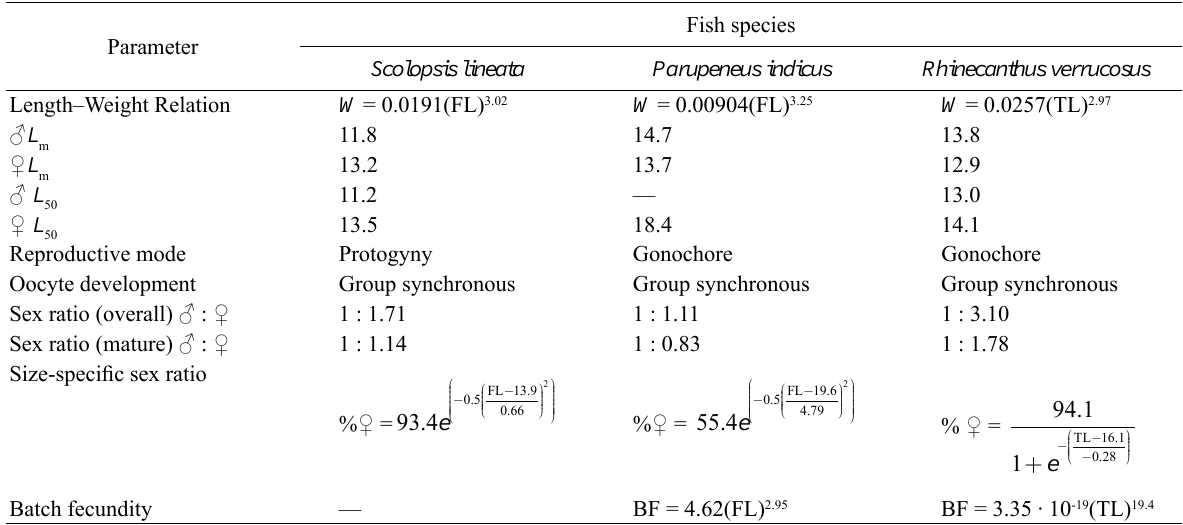
Summary of length–weight relations and reproductive information for striped monocle bream, Scolopsis lineata , Indian goatfi sh, Parupeneus indicus , and blackbelly triggerfi sh, Rhinecanthus verrucosus , from the Kamiali